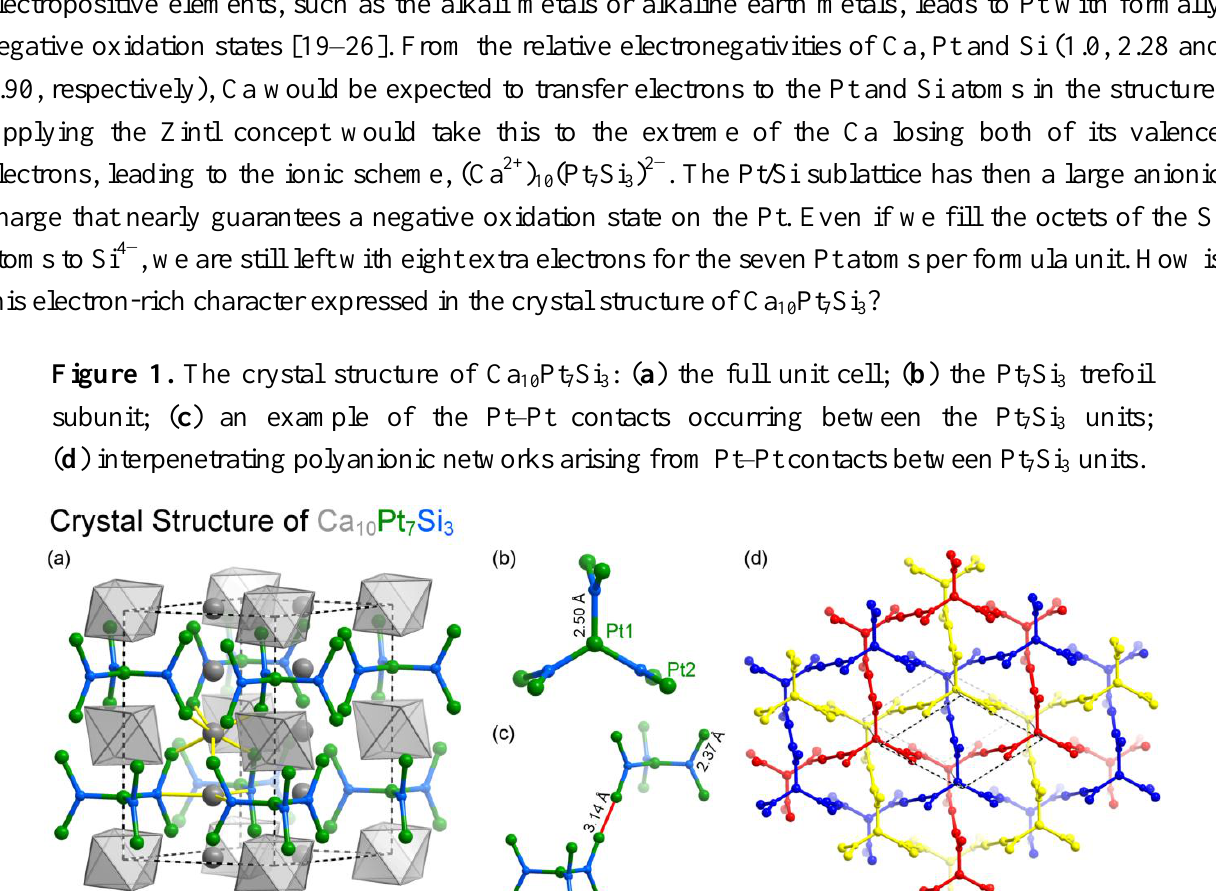
Pt Si : ( a ) the full unit cell; ( b ) the Pt 10 7 3